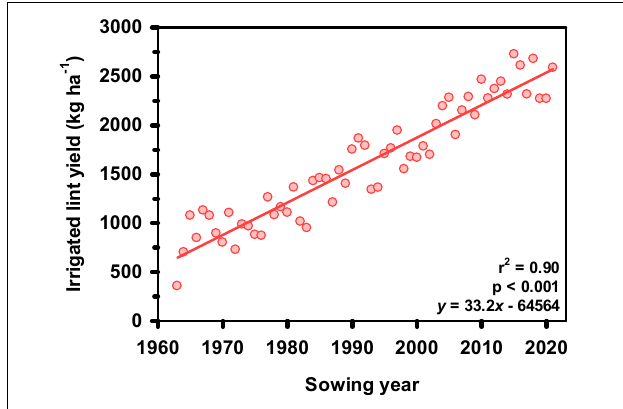
FIGURE 3 | Average Australian irrigated cotton industry yield (kg [lint] ha − 1 ) from 1962 to 2021. Source: The Australian Cottongrower Cotton